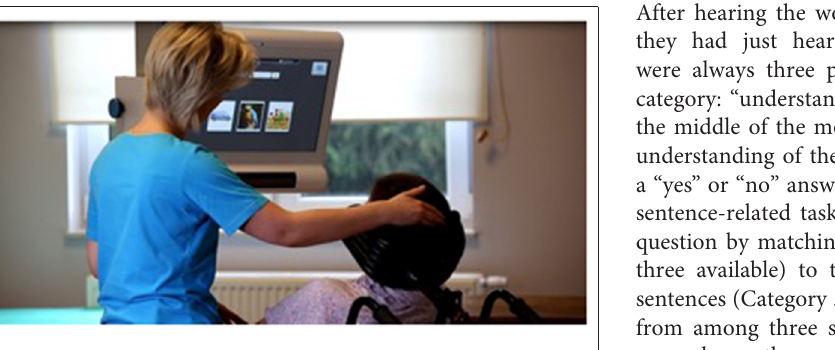
FIGURE 1 | Eye tracker: C-Eye (source: